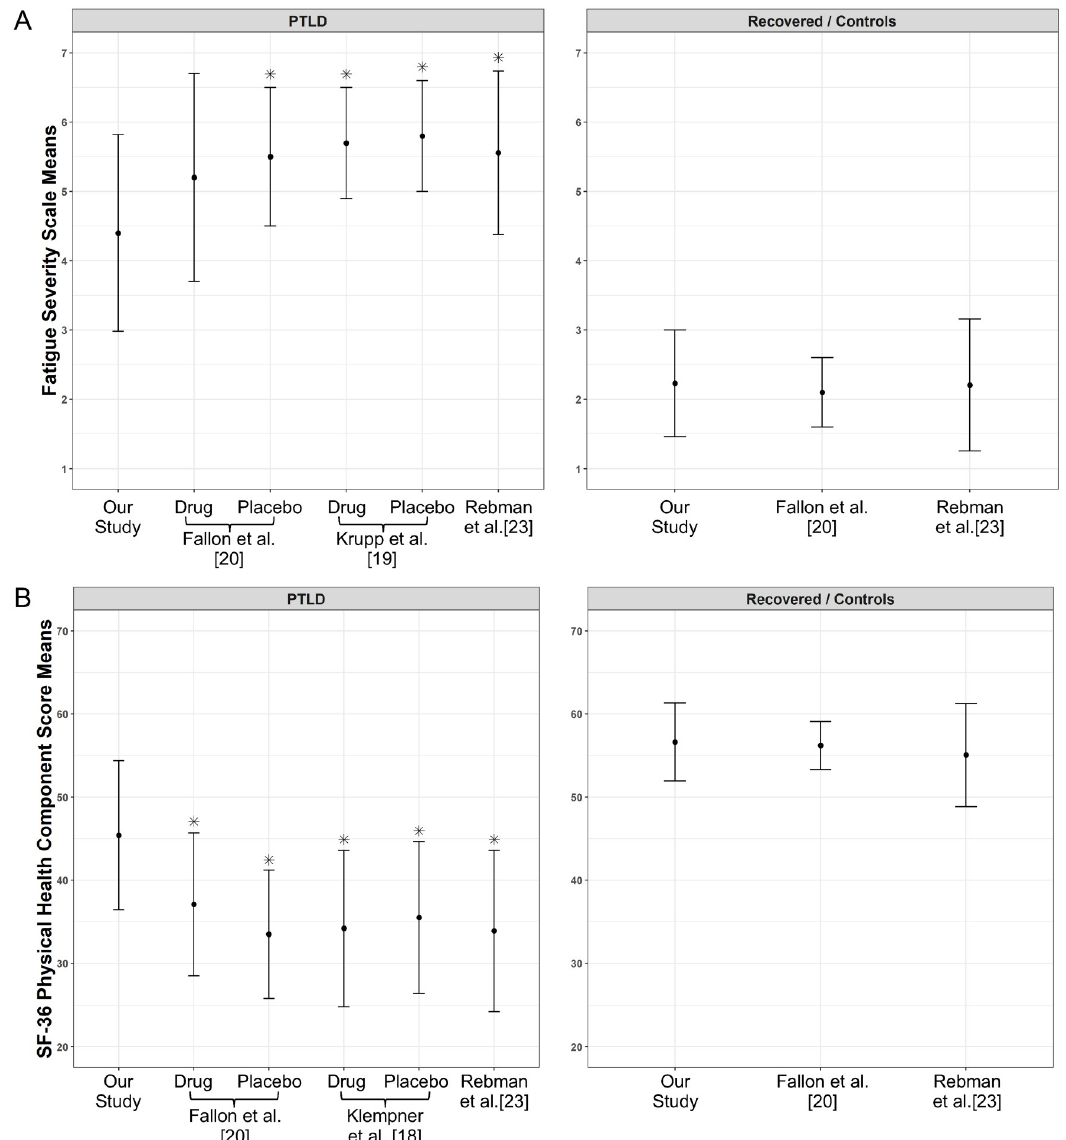
Fig 4. Comparison with other post-treatment Lyme disease symptoms or syndrome studies. We compared scores from our study with the scores from 4 studies (Klempner et al.[18], Krupp et al.[19], Fallon et al.[20] Rebman et al.[23]). The Fatigue Severity Scale and modified Fatigue Severity Scale mean scores, and the Physical Health component score of the Short form 36 and SF-36 v2 were compared, and the baseline assessment point was chosen for interventional studies. � Denotes statistical significance when compared to our study with a two-sample T-test at the alpha = 0.05 level after applying a Bonferroni correction based on the number of studies being compared to our study. PTLD: Post-Treatment Lyme Disease Symptoms or